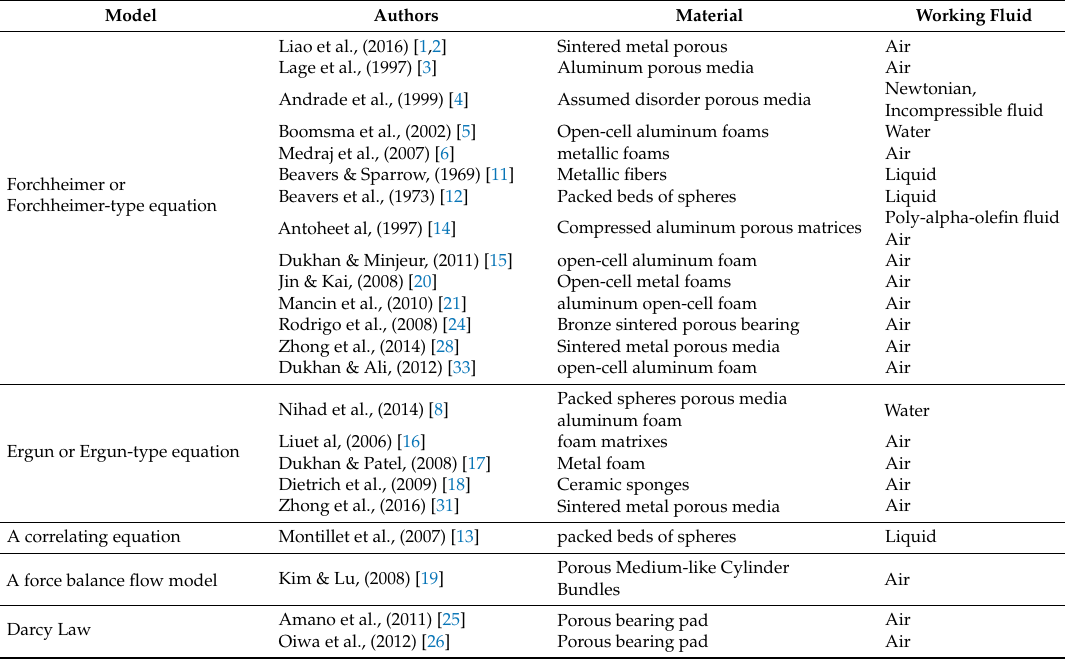
Figure 3. SEM images of magnified particles for some porous media. Table 1. Classification of the references.